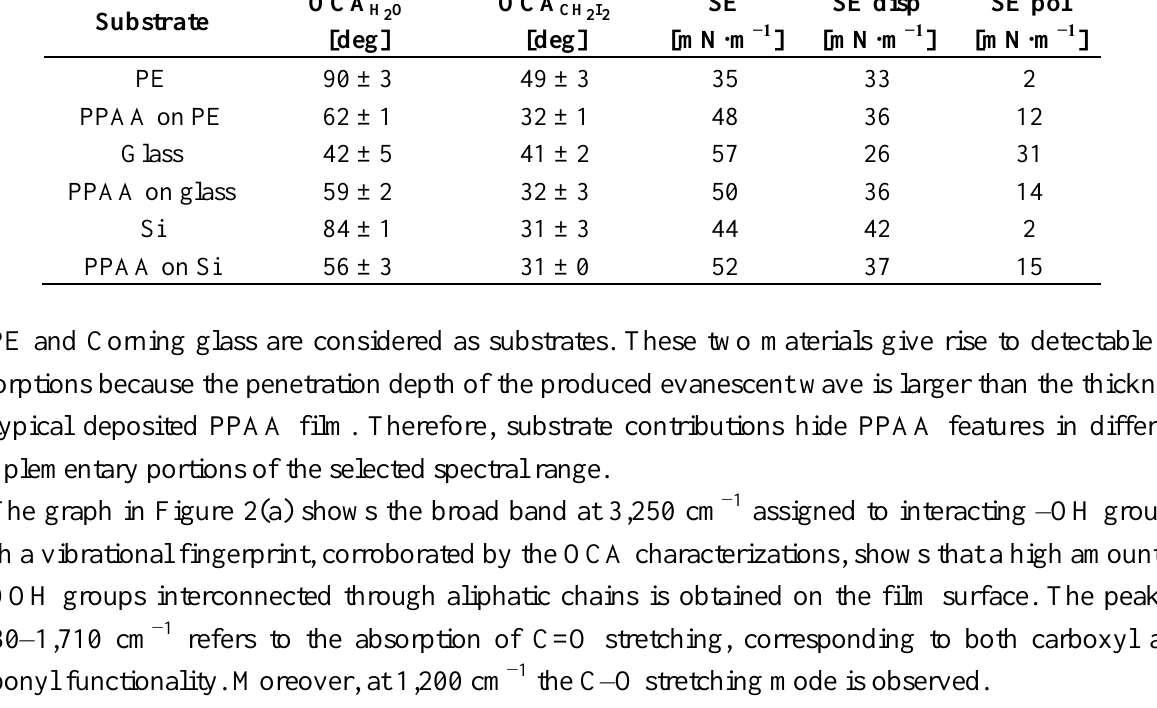
and OCA values on H2O CH2I2